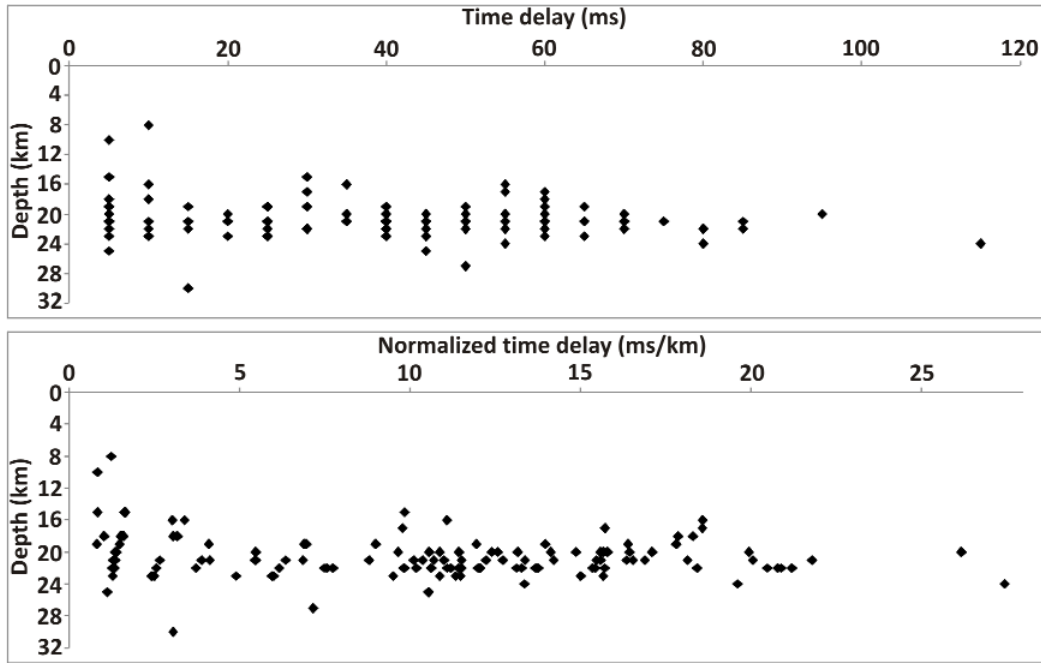
Figure 7. Raw and normalized time delays plotted versus the focal depth of all of the events used in this study, for both periods of interest. No systematic relations are seen between the time delays and the depth. The detected anisotropy is distributed above the depth of 15